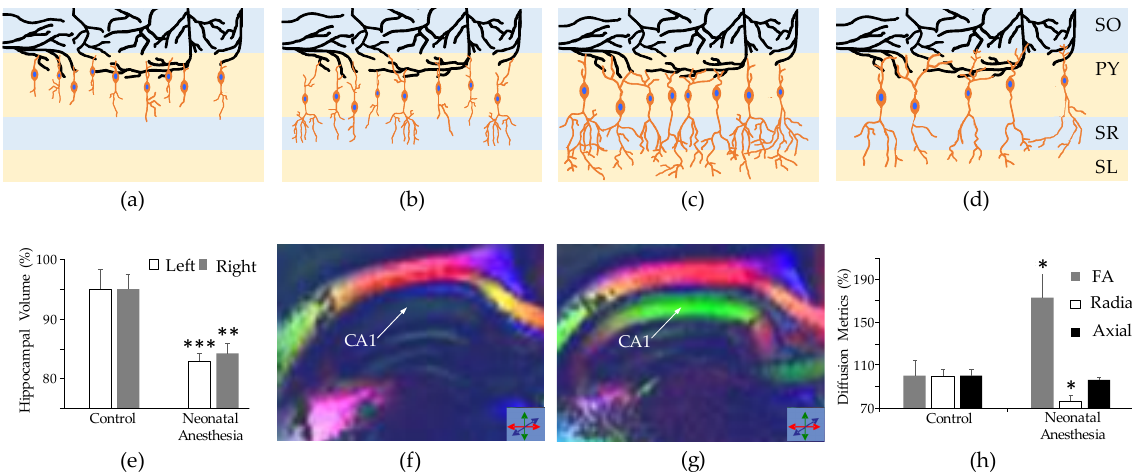
Figure 2. The impact of neonatal anesthesia on the development of interneurons in the hippocampus. ( a – c ) The schematic shows normal development of gamma aminobutyric acid (GABA)ergic interneurons (orange cell bodies with blue nuclei) in layers of the hippocampus. As the interneurons develop, ( a ) corresponds to the newborn state whereas ( c ) corresponds to the mature level of development), their axons lengthen and dendritic branches increase in complexity. Note, dendrites of target neurons (in black) are unchanged in the figures to demonstrate continuity of location in the observed neurons; in reality, they would also show morphological development concurrently with the interneurons. ( d ) Following exposure to neonatal anesthesia, we expect to see a decrease in the number of interneurons and reduction in their dendritic complexity. To compensate for the decrease in their quantity, interneurons can increase axonal length and number of targets. The following were adapted from our previous study [113]. ( e – h ) The results of a comparative analysis between control subjects and those exposed to neonatal anesthesia are shown. ( e ) Volumetry of the adult rabbit hippocampus revealed a significant reduction in the hippocampal volumes of subjects exposed to neonatal anesthesia. ( f , g ) Fractional anisotropy (FA) maps of representative adult subjects from the control ( f ) and neonatal anesthesia ( g ) groups show significant changes in the direction of water diffusion, with the most notable changes in the CA1 region (indicated by the arrows) ( h ), which exhibited a significant increase in FA and decrease in radial diffusivity, indicative of lower levels dendritic branching and neurodegeneration (represented in ( d )). The layers of the hippocampus shown in ( a – d ) are labeled as follows: stratum oriens (SO), pyramidal cell (PY), stratum radiatum (SR) and stratum lacunosum-moleculare (SL) layer. ( e , h ) Statistical significance is indicated by the asterisks: one asterisk indicates p < 0.05, two asterisks indicate p < 0.01 and three asterisks indicate p <